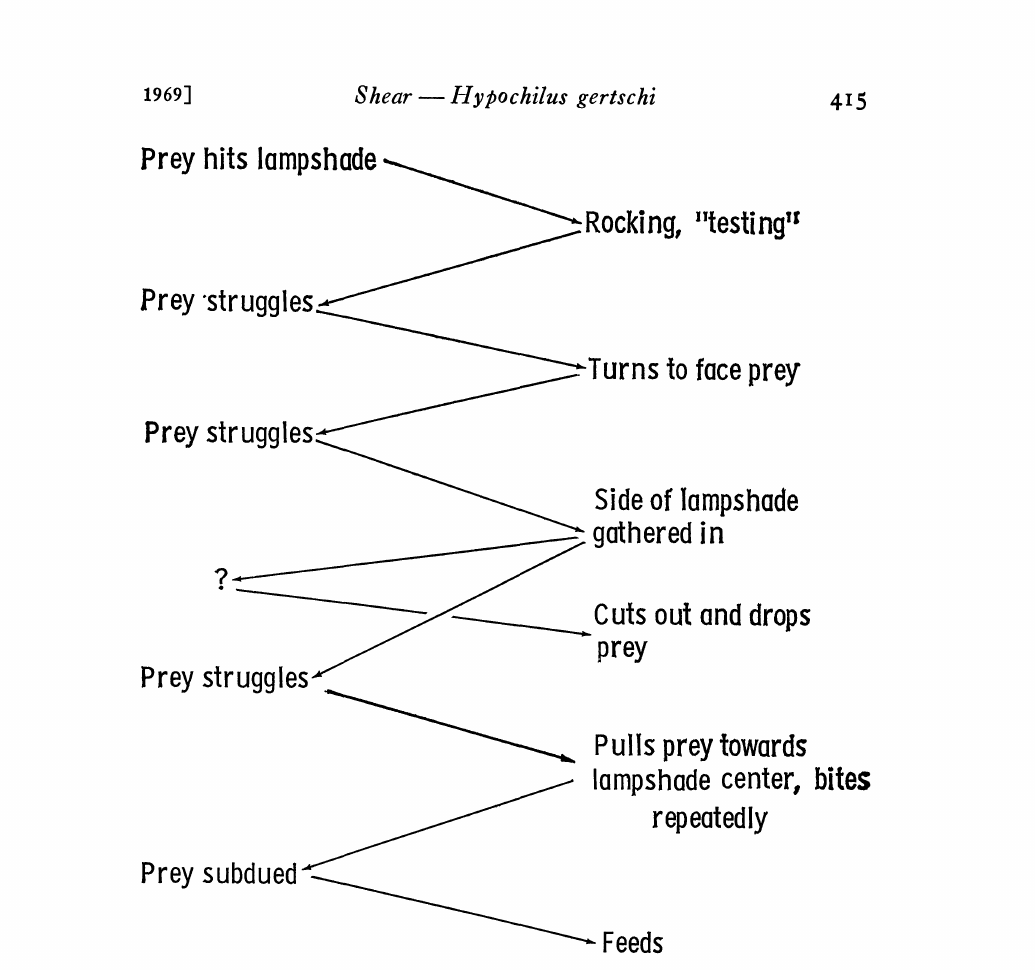
Fig. 9. Typical attack sequence o.f Hyochilus gertschi. drop to the ground. Once on the ground, the spider remained inert with the legs drawn up over the carapace. Return to the web involved or the. attachment point o the tangle, which was a laborious search then climbed until the spider could re-enter the lampsha,de. In two cases, escaped individuals ound the webs o other individuals and attempted to climb them. When they reached the lampshade, they were repulsed by the